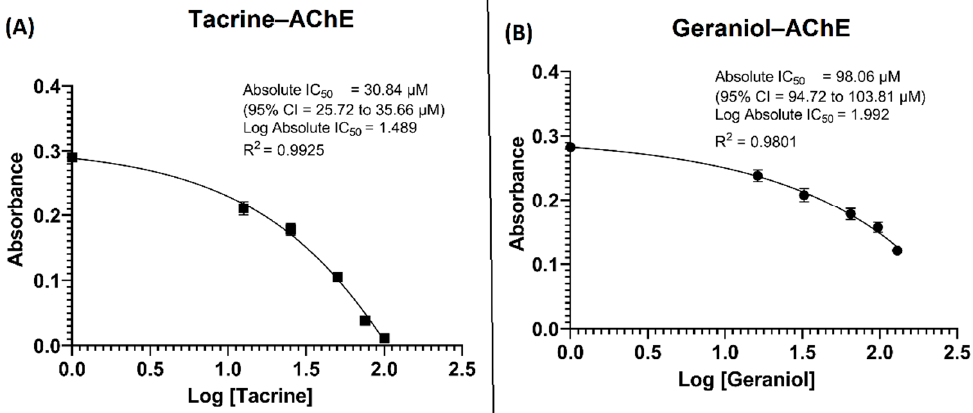
Figure 2. Influence of the ( A ) tacrine and ( B ) geraniol concentrations on acetylcholinesterase inhibi ‐